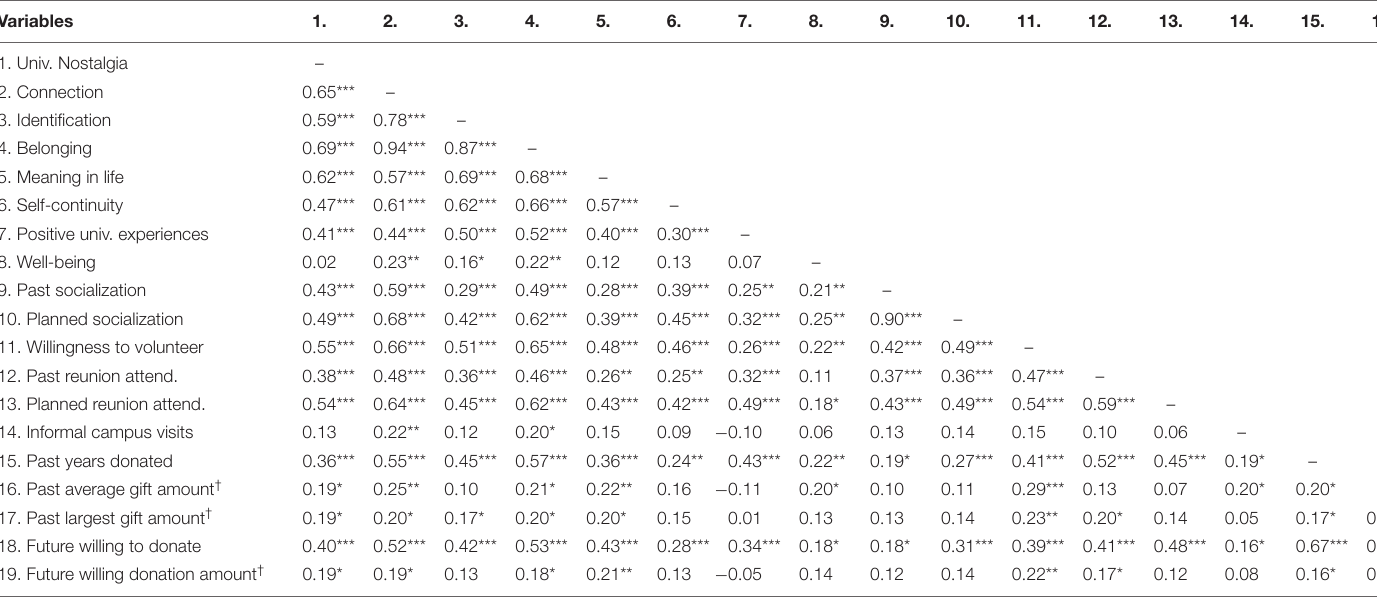
TABLE 5 | Bivariate correlations among study 2 variables ( N = 161).